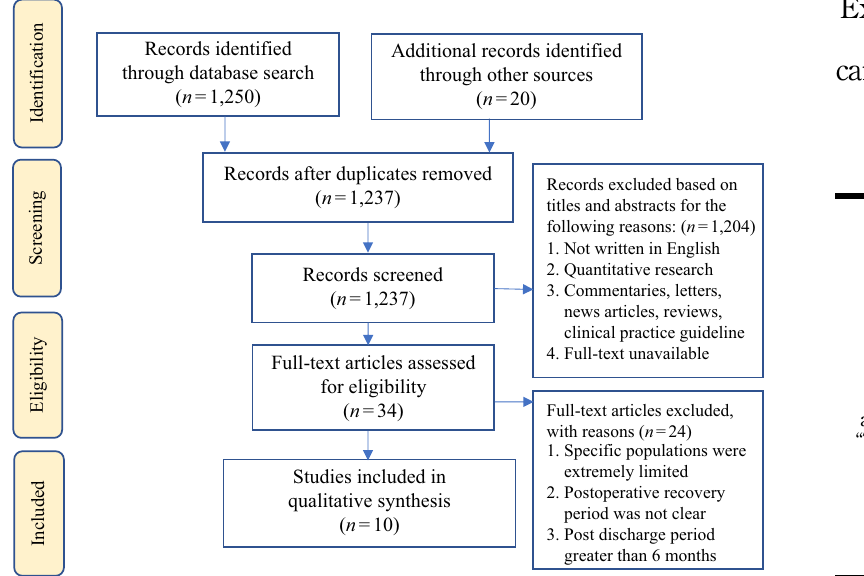
Figure 1. PRISMA 2009 flow diagram adapted to examine “ The Experiences of Colorectal Cancer Patients during